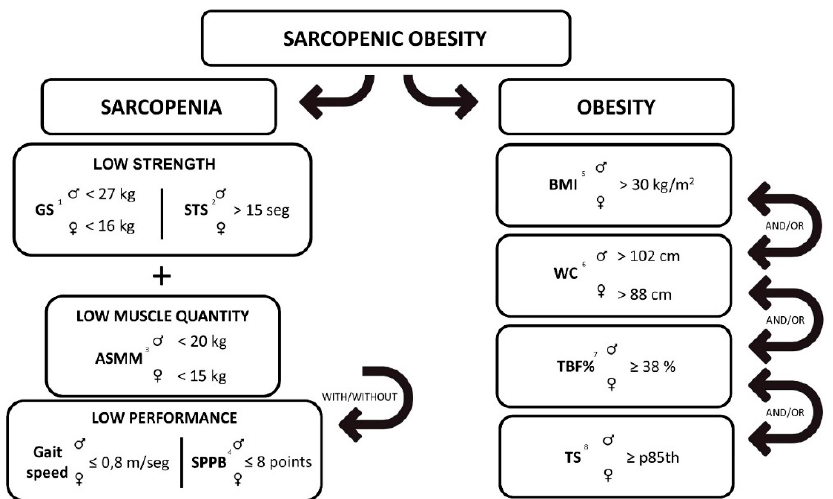
Figure 1. Sarcopenic obesity diagnosis algorithm: strength determined by grip strength (GS) and/or the sit-to-stand test (STS); muscle quantity determined by appendicular skeletal muscle mass (ASMM); low performance determined by gait speed and/or the Short Physical Performance Battery (SPPB) test; and obesity determined by body mass index (BMI), waist circumference (WC), total body fat percentage (TBF%), and/or triceps skinfold (TS).